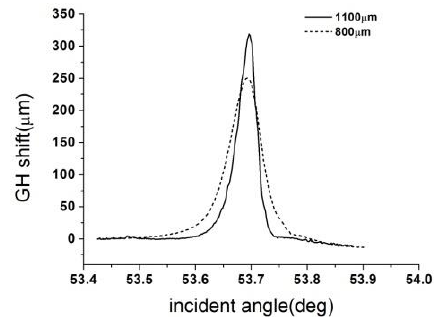
Figure 7. Measured GH shift curves for two different waist radiuses of incident beam.